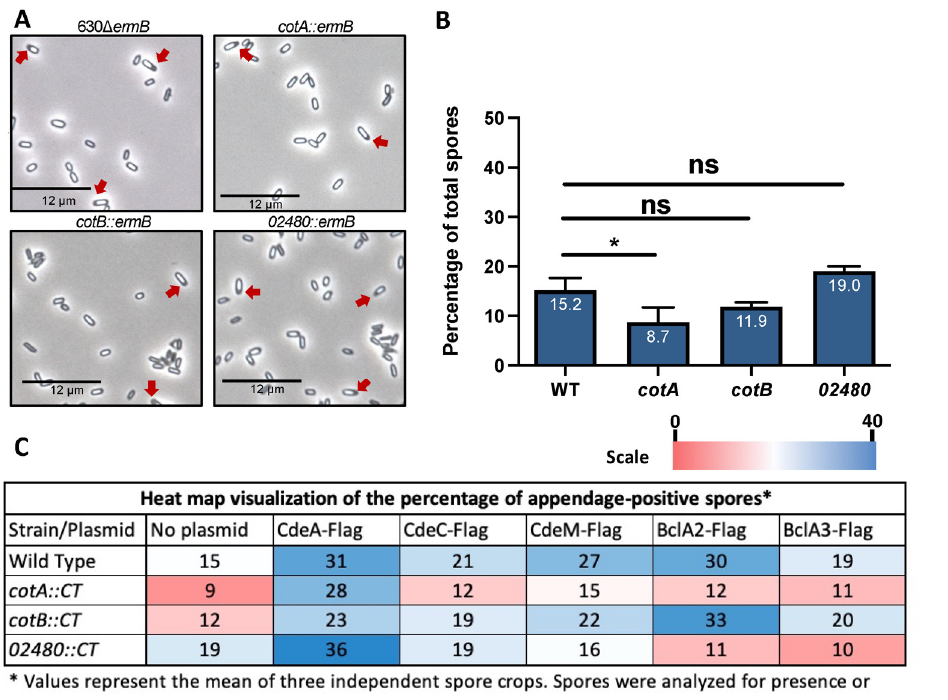
Figure 3. Effect of absence of coat proteins in the spore appendage of C. difficile spores. Spores